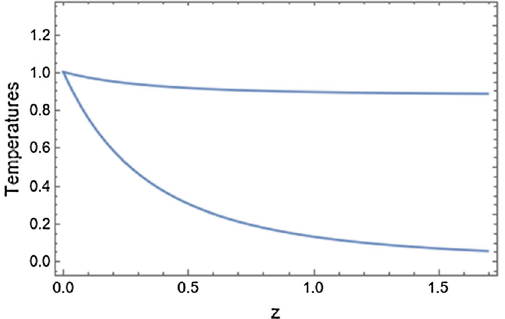
Fig. 2 We display the reconstructed temperatures for model (i) using the expressions (35, 36) using all the data. The upper line is T m ( z )/ T m ( 0 ) and the lower one is T x ( z )/ T x ( 0 )